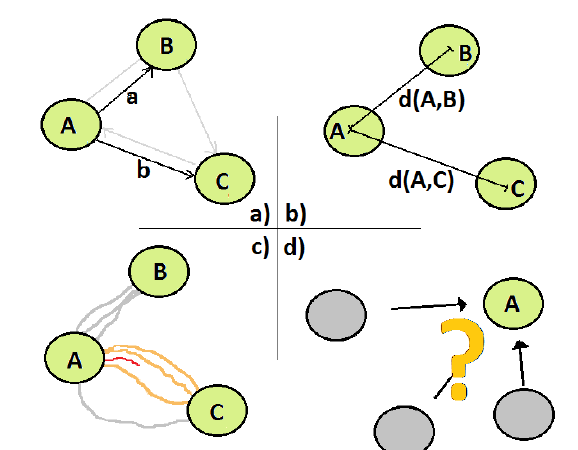
Figure 2: The probability value depends on four factors: (a) the preferred target of other individuals, (b) the distance to possible targets, (c) the similarities concerning the shape and parameters of the current to other way segments, (d) the already passed